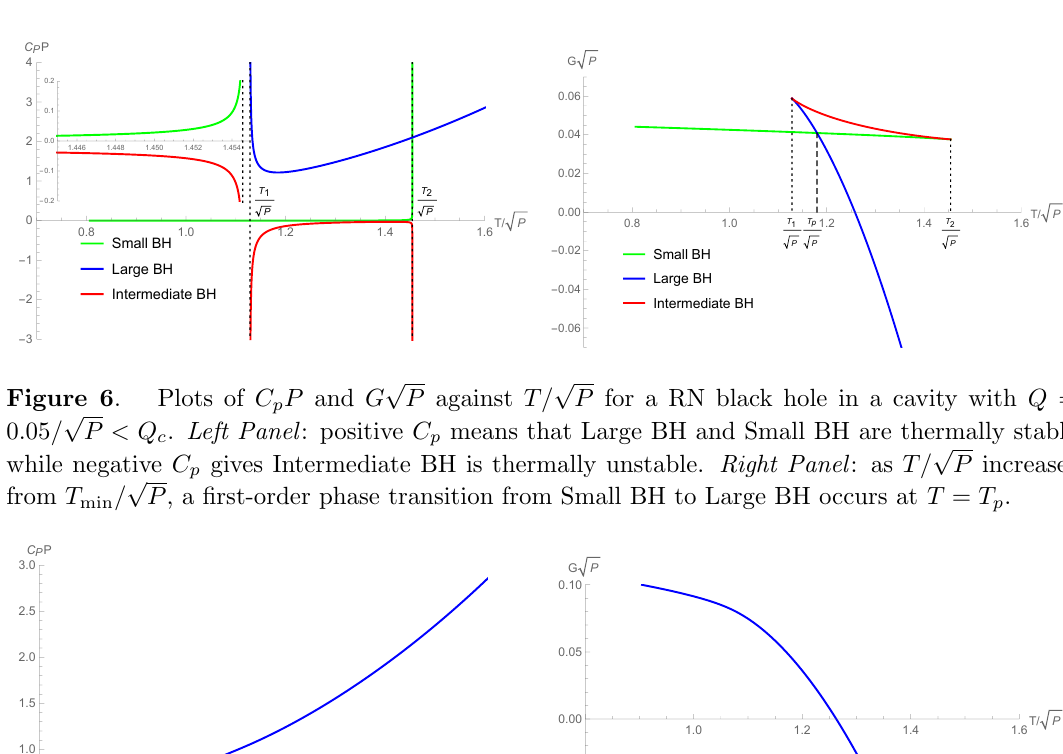
Figure 7 . Plots of C p P and G p 0 : 15 = P > Q c . Left Panel : the only phase has positive heat capacity and hence is thermally stable. Right Panel : there is no phase